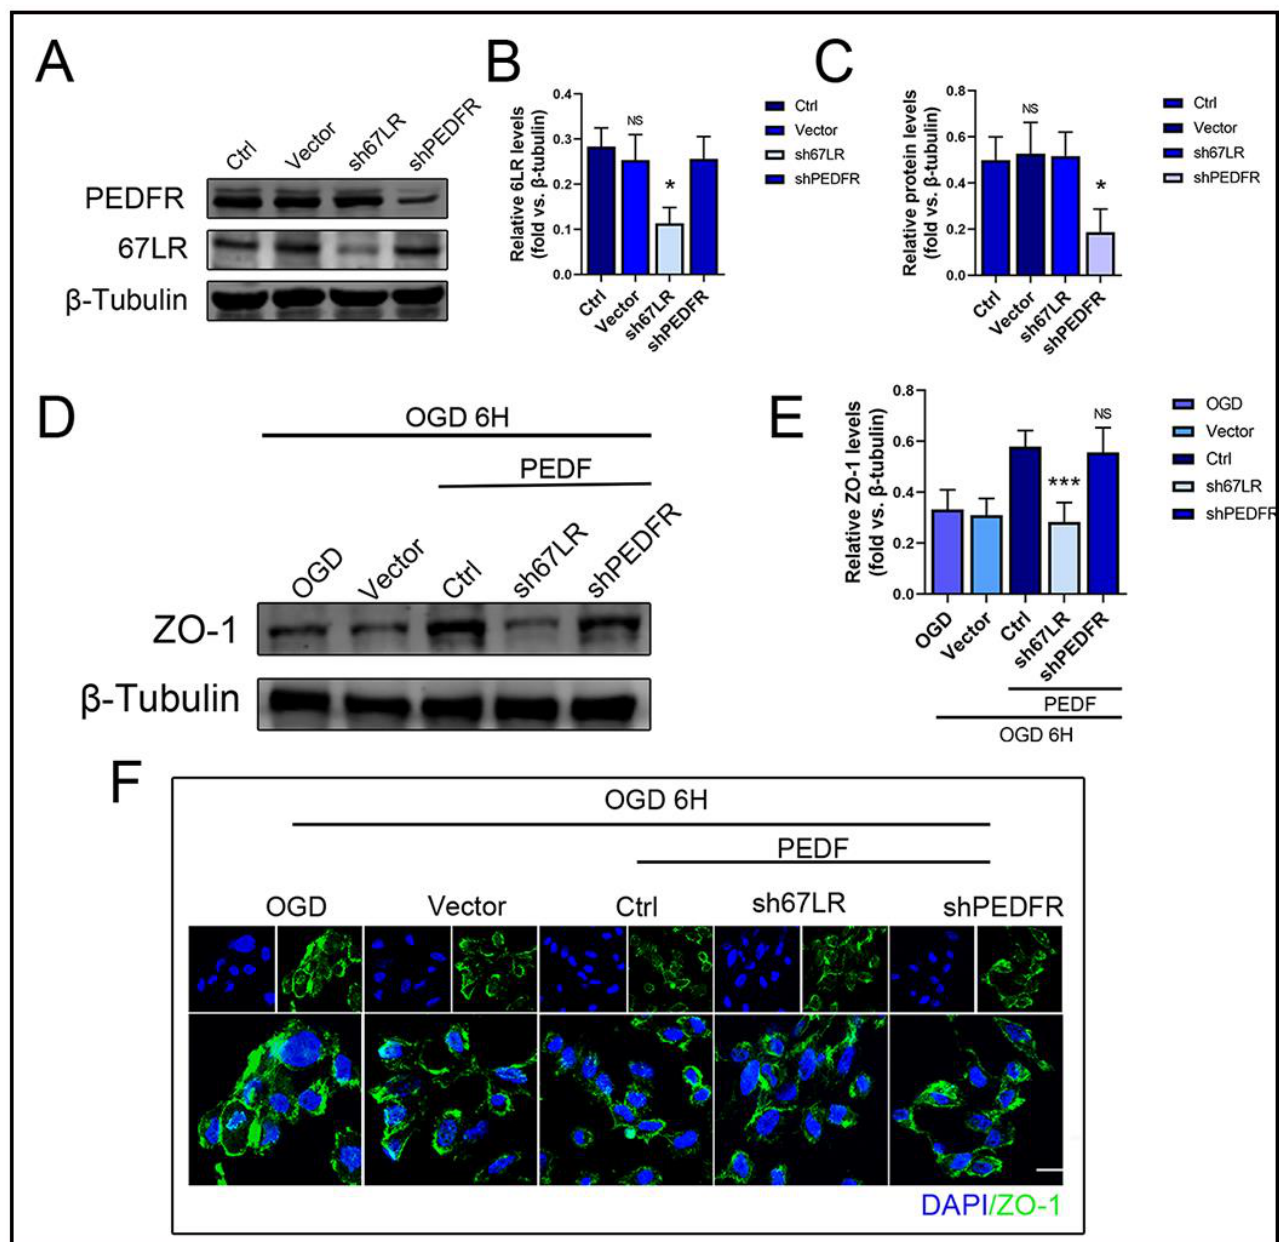
Figure 4. PEDF maintains endothelial tight junction stability through 67LR. ( A – C ) Transfection with both 67LR and PEDFR viruses was successful. ( D , E ) Western blotting to detect the effect of PEDF on the expression of ZO-1 in vitro; ( F ) Immunofluorescence to observe the effect of PEDF on the distribution of ZO- 1 in vitro. Scale Bar = 200 μm. Data are expressed as mean ± SD; n = 6; NS, no significant difference; * p < 0.05; *** p < 0.001.